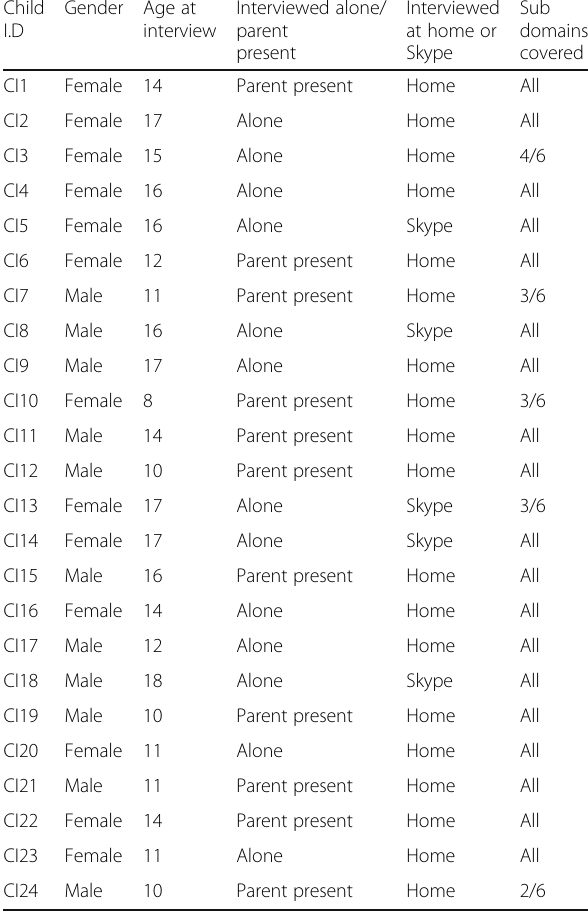
Table 3 Participants taking part in cognitive interviews Child